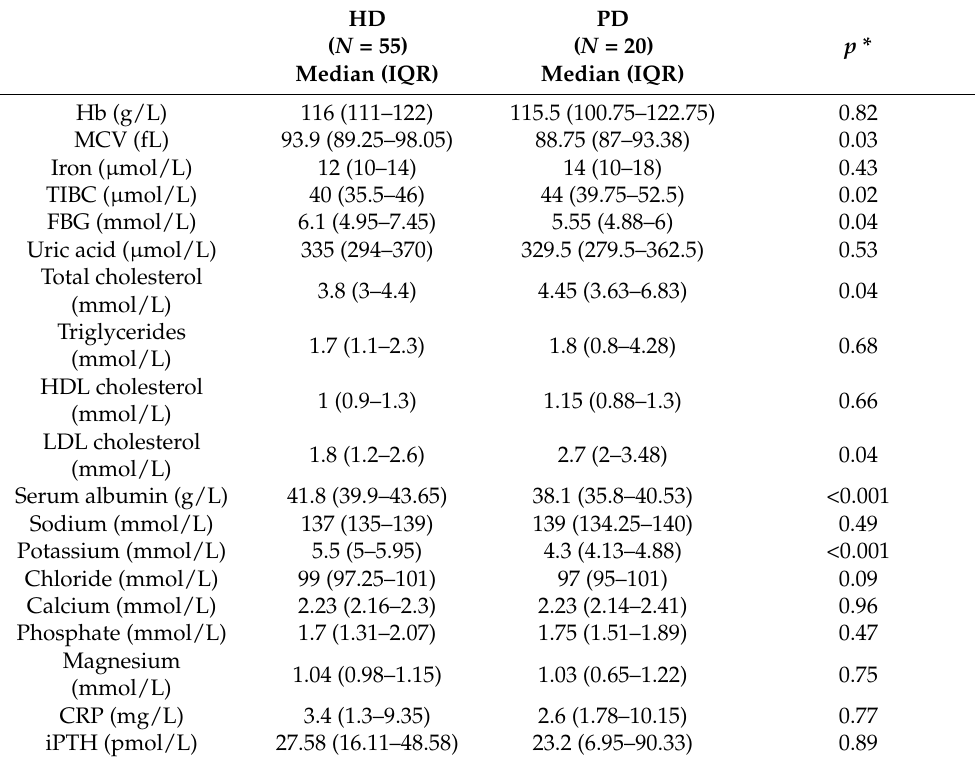
Table 2. Biochemical parameters and differences regarding dialysis